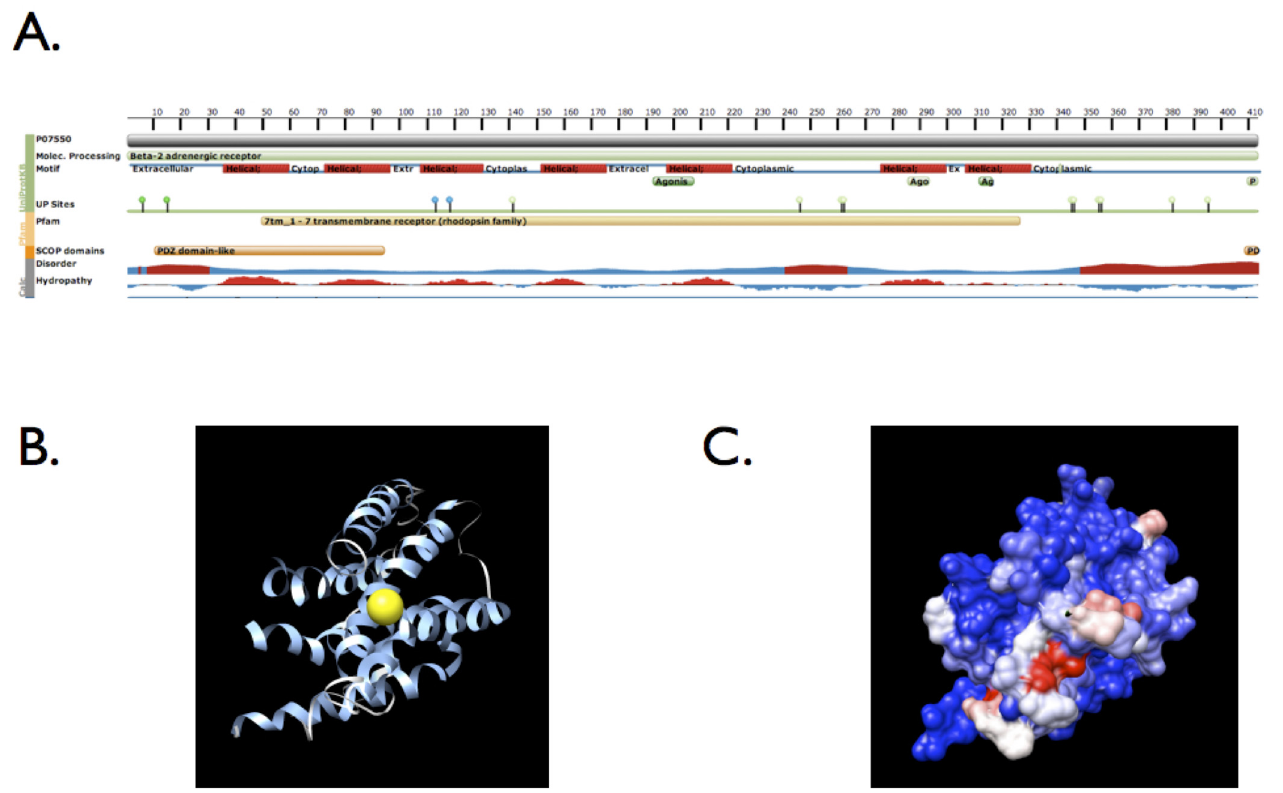
Fig 3. Structural domains and crystal structure of ADRB2 (protein databank [PDR] structure 2r4r, images from LS-SNP/PDB [51]). (A) Structural domains of ADRB2; rs1800888 is located in amino acid residue number 164 within a helical transmembrane domain (protein databank [PDB] structure 2r4r) ( B) crystal structure of ADRB2 showing the location of rs1800888; solvent accessibility for the amino acid residue at rs1800888 is 41% (exposed). (C) Position conservation within protein superfamily (G-protein coupled receptor 1 family), red = high conservation, blue = low; 32% of protein sequences in the alignment contain the most frequent amino acid residue at